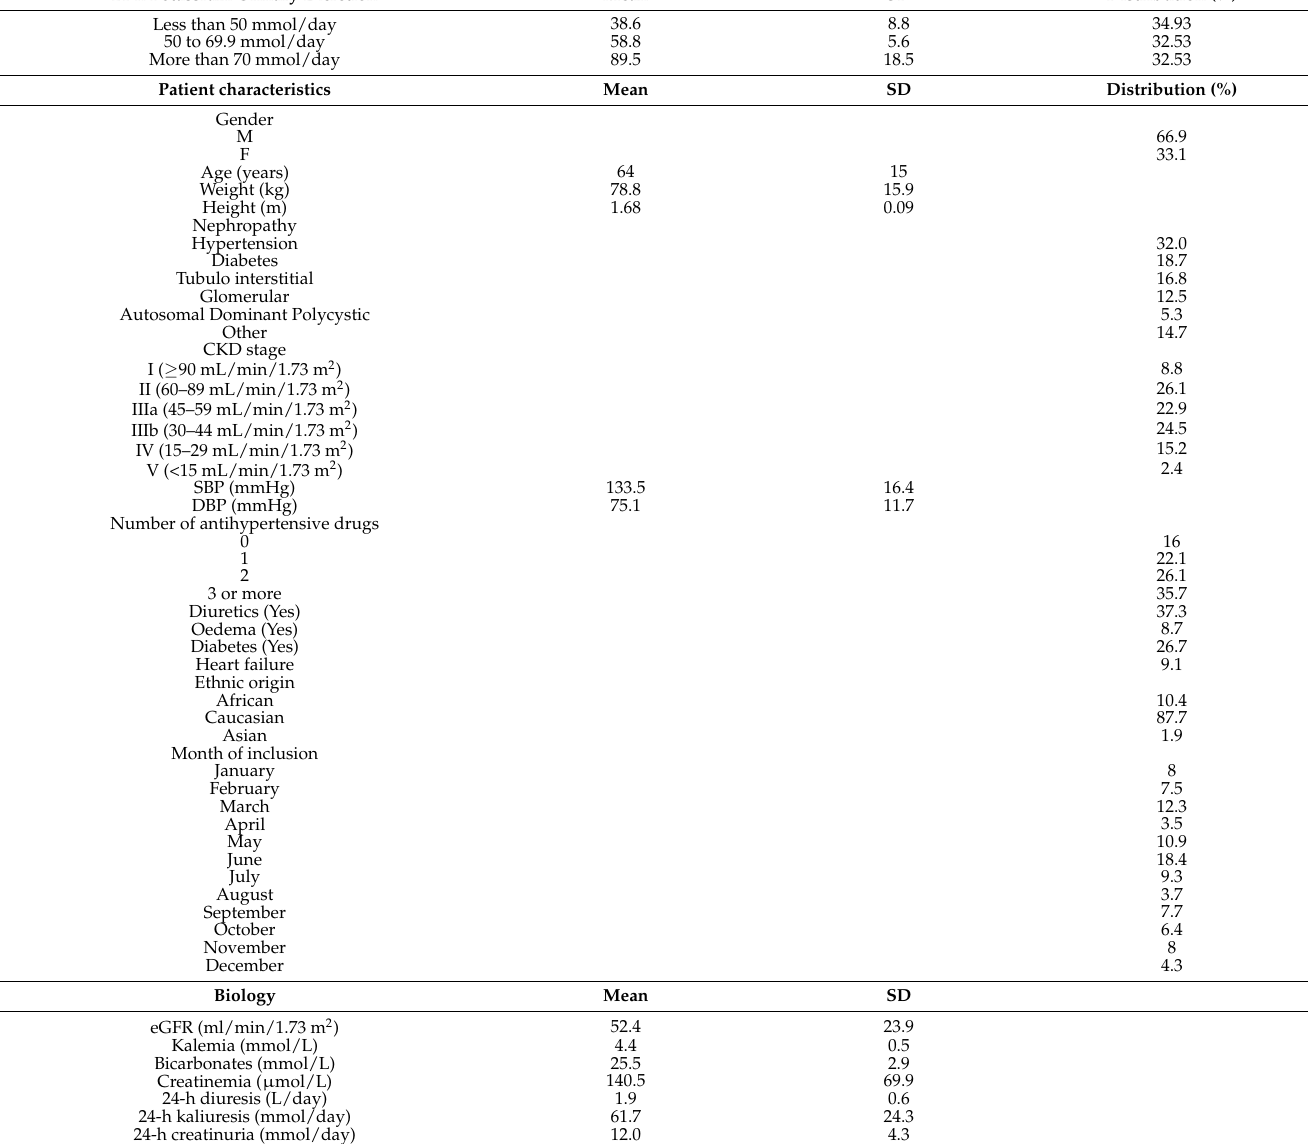
Table 1. Characteristics of CKD patients included in the UniverSel